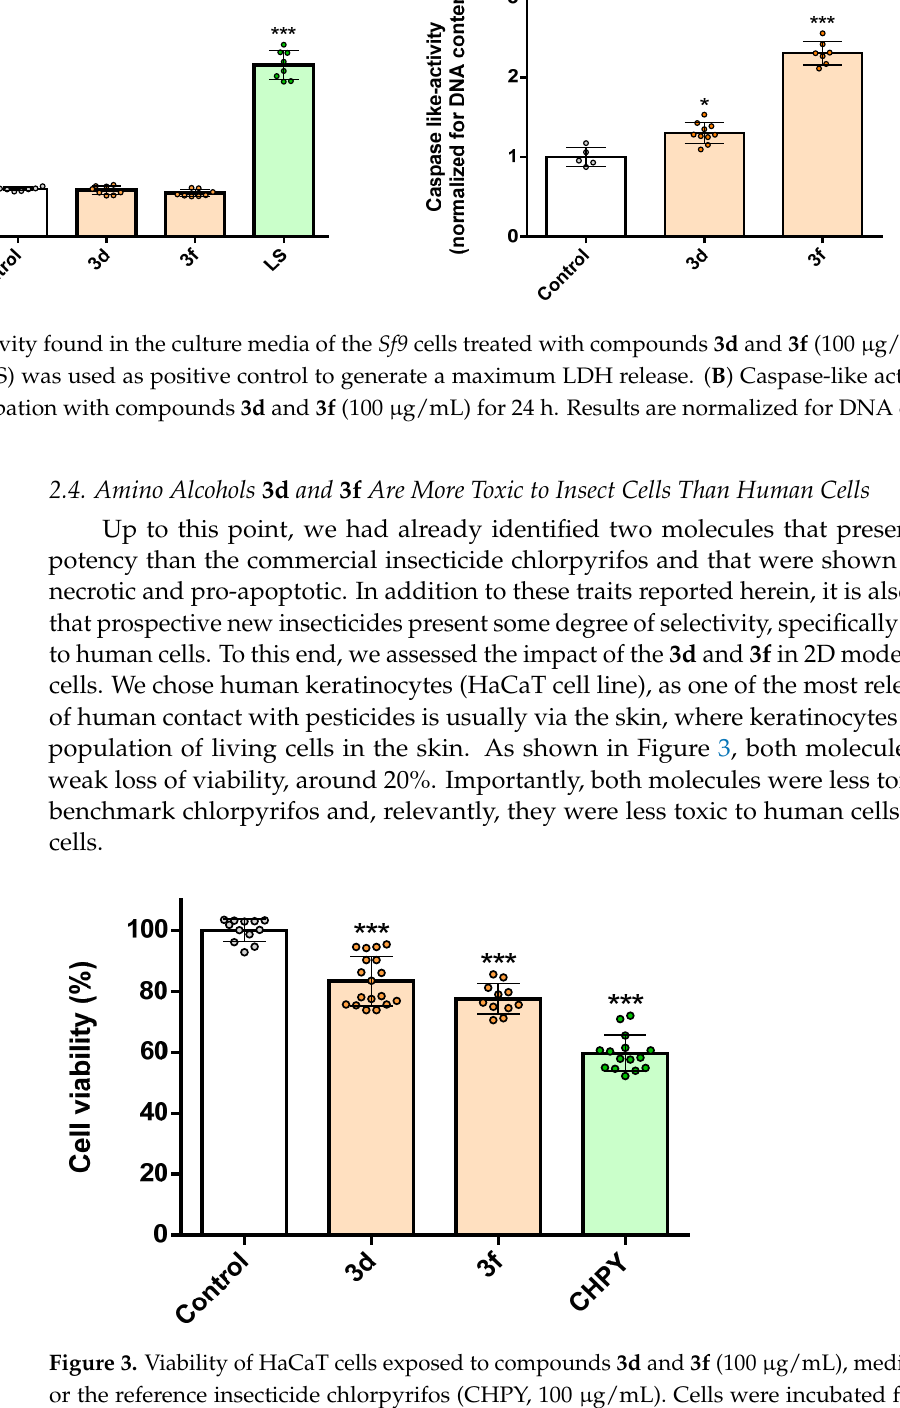
Figure 3. Viability of HaCaT cells exposed to compounds 3d and 3f (100 µg/mL), medium